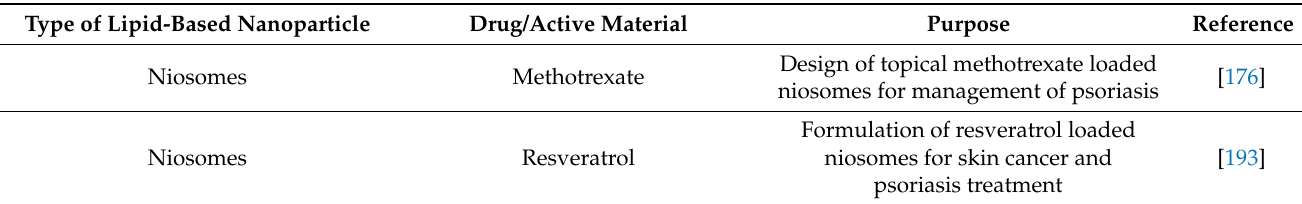
Table 2. Recent studies on dermal/transdermal drug delivery systems comprising nanovesicular carriers. Type of Lipid-Based